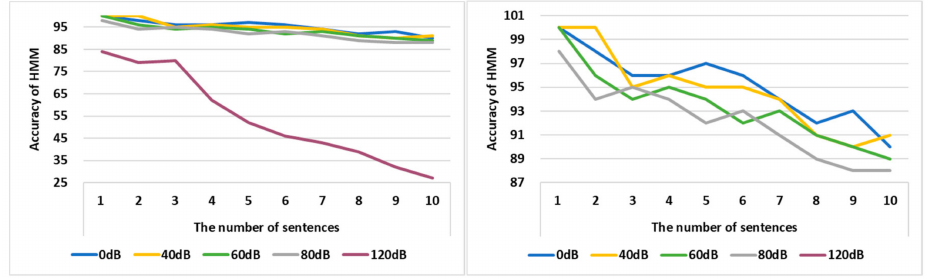
Figure 12. The accuracy of the HMM according to noise.